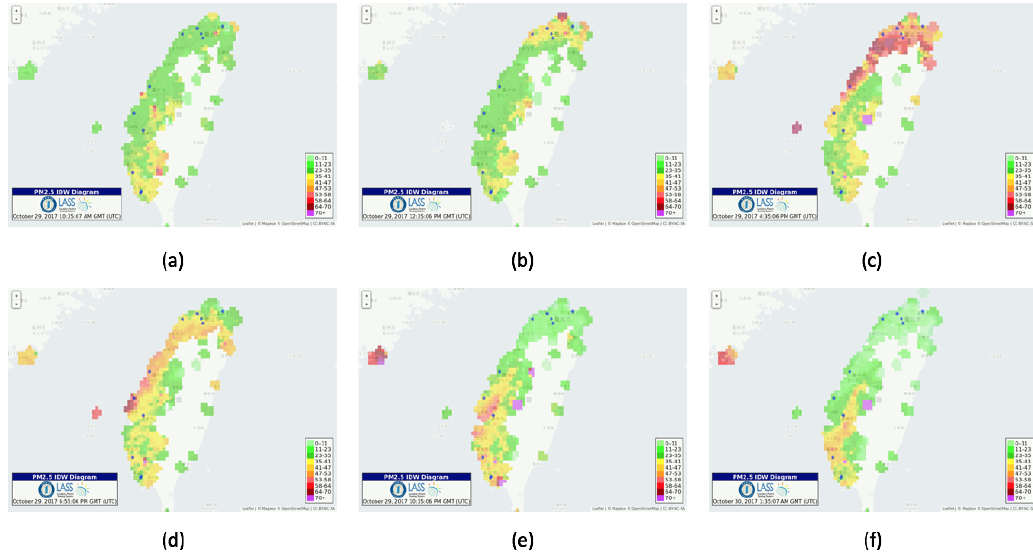
Figure 6. ( a – f )—IDW animation for a pollution